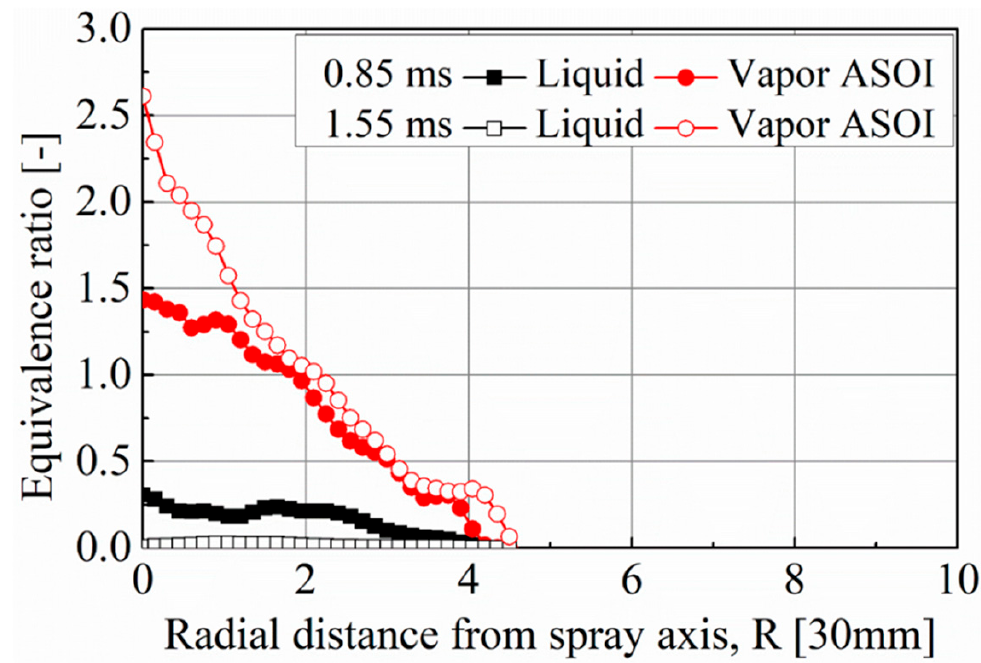
Figure 9. Radial distribution of liquid and vapor phases equivalence ratio at an axial distance of 30 mm from nozzle tip (T a = 800 K, P a = 4.8 MPa, P inj = 100 MPa, M f = 5.0 mg). The first peak can be found at a distance of around 10 mm along the spray axis. It is unclear. However, it should be noted that there is a relatively large uncertainty in the determination of the vapor phase equivalence ratio due to the evaluation of a narrow spray close to the invisible area in the presence of a very high drop density. As the spray evolves, the second peak appears closer to the spray tip, according to the stagnation region. In short, the shape of curves is something like a saddleback [28]. On the other hand, the liquid phase equivalence ratio curves show a single peak that reduces with axial distance, indicating that the fuel evaporates at the same rate as it is injected. The vapor phase equivalence ratio curves are higher than the liquid phase equivalence ratio curves, as shown in Figure 9. The curves of vapor show that the equivalence ratio decreases with respect to radial distance from the centerline of the spray axis (Gaussian shape). This suggests that as the fuel spray penetrates further, greater air entrainment occurs. However, this far downstream, the liquid phase equivalence ratio is quite low and close to zero at 1.55 ms ASOI. This means that as the air-fuel mixing quality improves, the majority of the liquid fuel evaporates and is transformed to